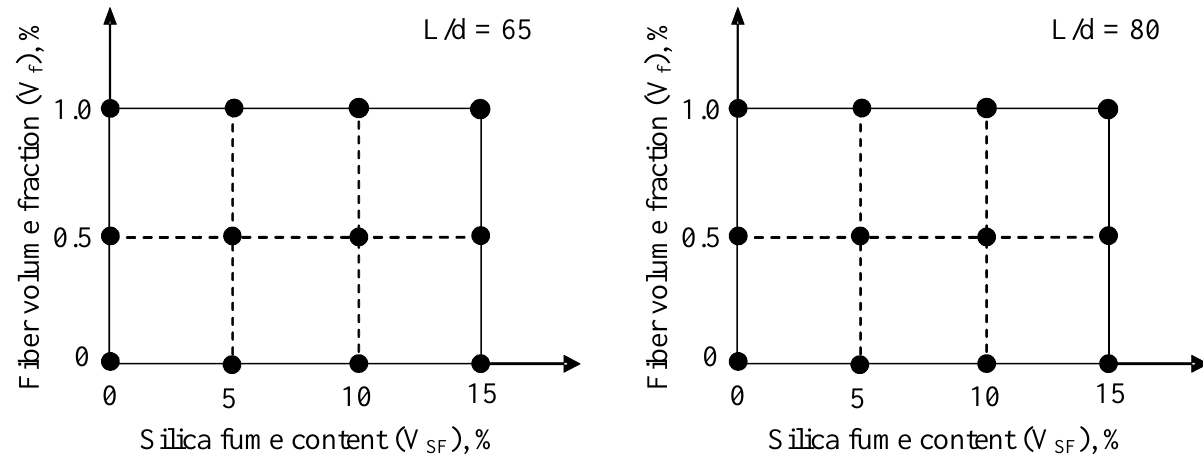
Figure 1. Experimental design schemes. Twelve experimental data for each response (fracture toughness and splitting tensile strength) of concretes were fitted to the mathematical model by variance analysis (ANOVA). Regression models of mechanical properties of concretes fitted are given below: Equations (15) and (16) for the mixtures with an aspect ratio of 65: Equations (17) and (18) for the mixtures with an aspect ratio of 80: Response surfaces of f st and T as a function of volume fractions of SF and steel fibers with 65 and 80 aspect ratios are given in Figures 2 and 3.